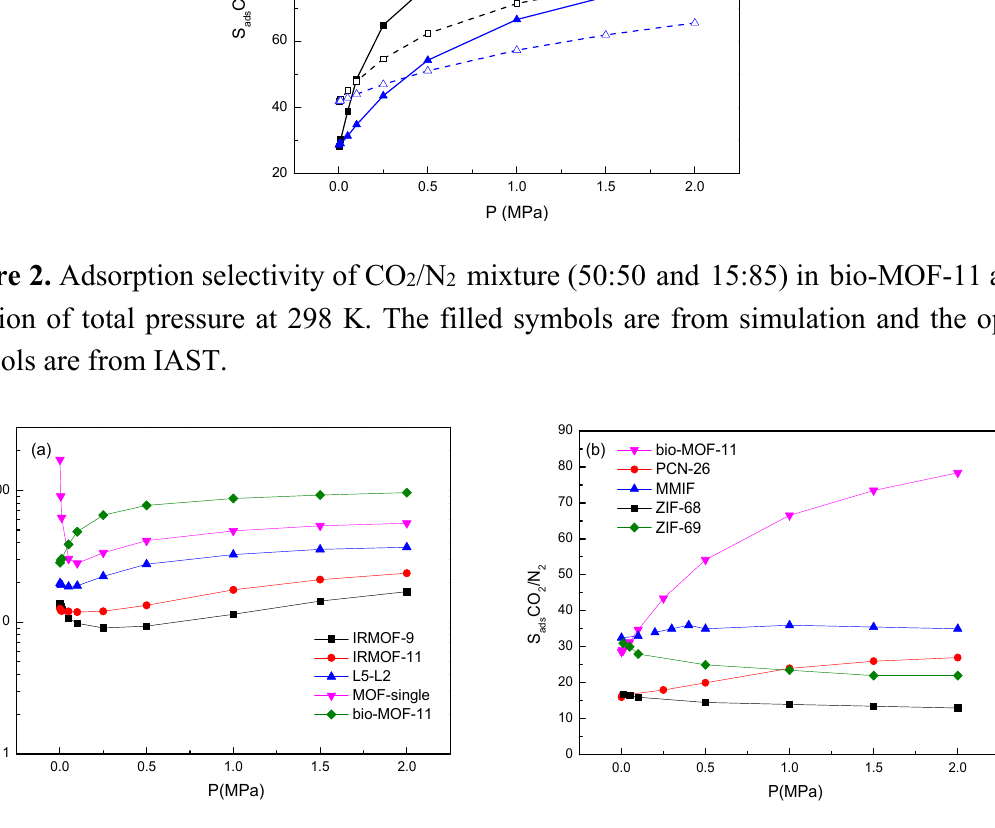
Figure 3. Comparison of adsorption selectivities for ( a ) equimolar and ( b ) 15:85 binary gas mixtures of CO 2 /N 2 as a function of total bulk pressure in bio-MOF-11 with other eight MOFs at 298